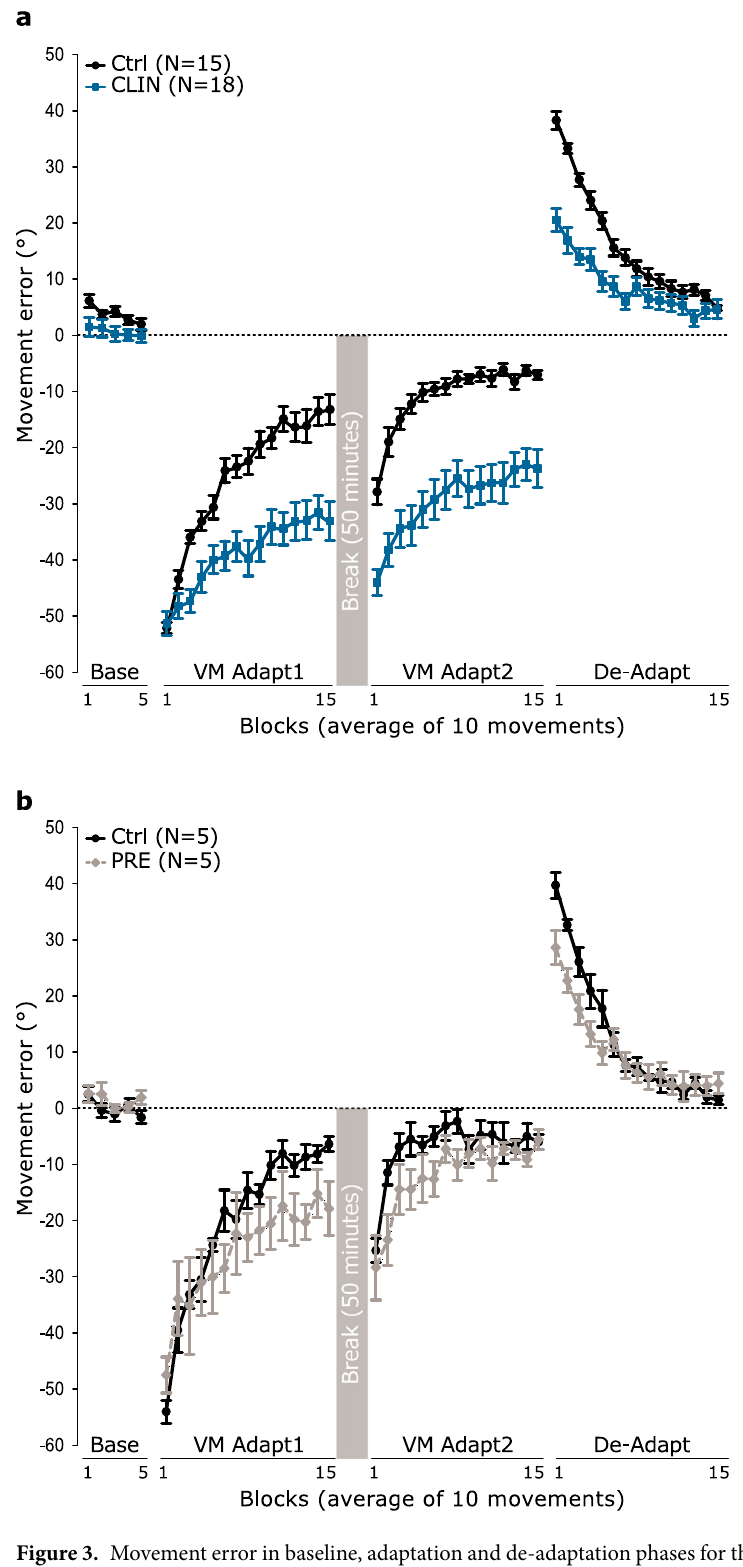
Figure 3. Movement error in baseline, adaptation and de-adaptation phases for the CLIN patients ( a ) and the PRE individuals ( b ). Movement error in degrees is represented in blocks of 10 trials throughout the different experimental phases: baseline, visuomotor adaptation 1 and 2 (VM Adapt1 and VM Adapt2) and de-adaptation (De-Adapt) for the CLIN patients (blue squares and lines), the PRE individuals (grey diamonds and dashed lines) and their respective control groups (Ctrl: black disks and lines). The 50-minutes break is represented by a grey square between VM Adapt1 and VM Adapt2. Negative (positive) errors correspond to anti-clockwise (clockwise) deviation relative to the target. Error bars are standard errors of the